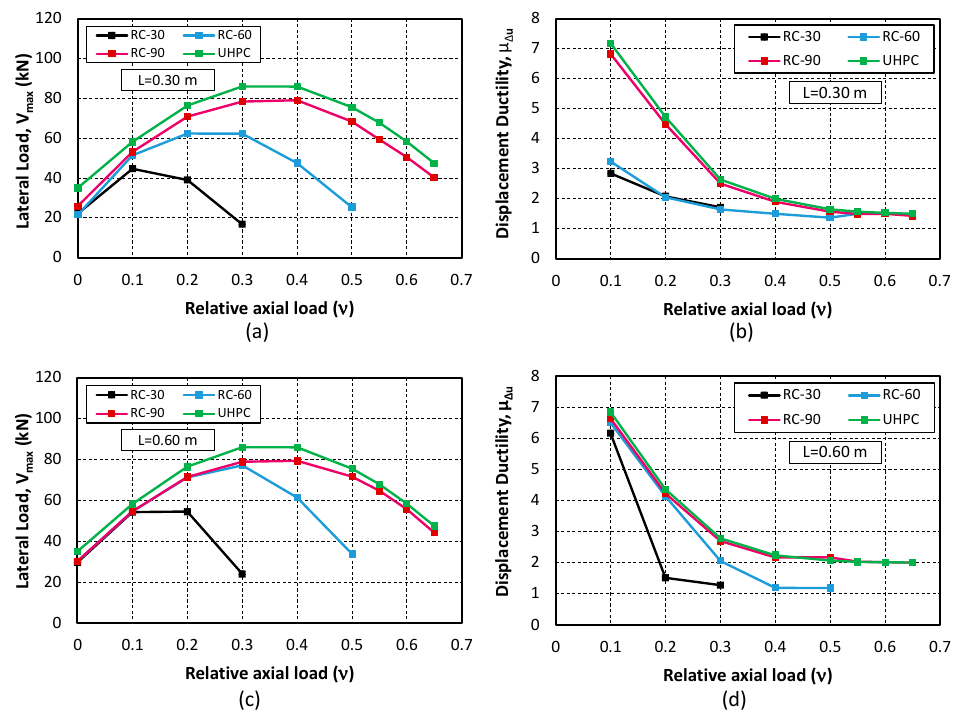
Figure 15. Maximum load and displacement ductility in the specimens made with UHPC–NiTi bars at the hybrid connection and secondary concrete and steel reinforcement in the rest of the column. Discontinuous joint (Phase 5): ( a ) lateral load–relative axial load for L = 0.3 m; ( b ) displacement ductility–relative axial load for L = 0.3 m; ( c ) lateral load–relative axial load for L = 0.6 m; ( d ) displacement ductility–relative axial load for L = 0.6 m.